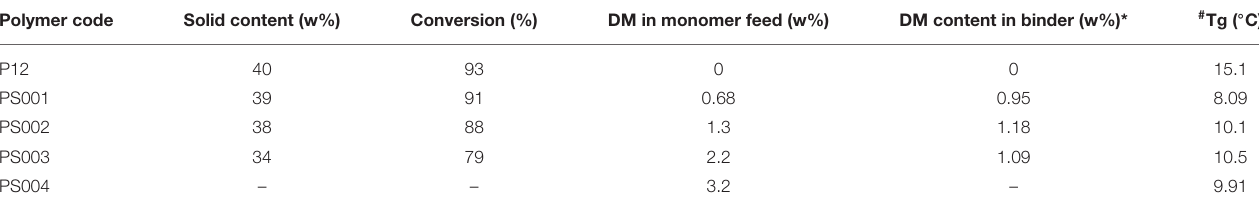
TABLE 2 | Theoretical and estimated deltamethrin (DM) content in binder emulsion and glass transition temperature (Tg). Polymer code